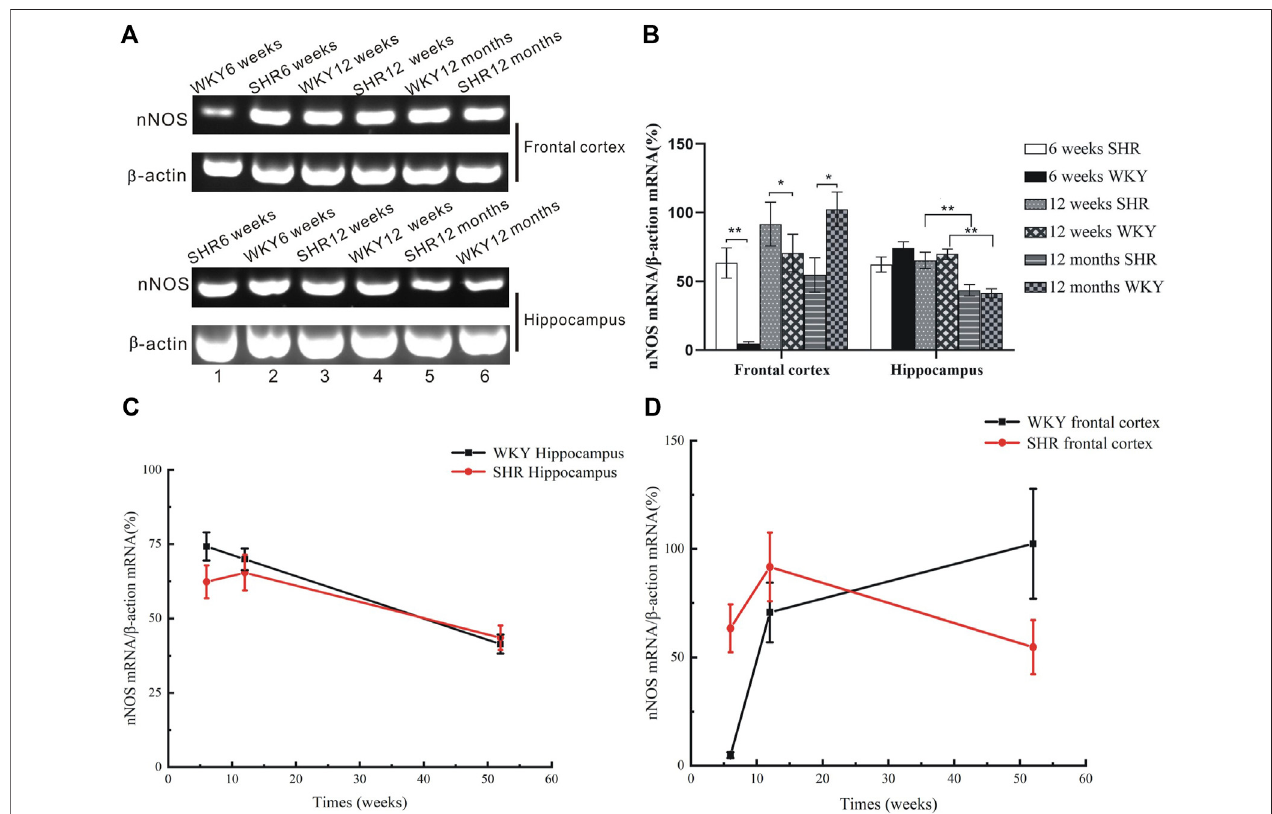
FIGURE 2 | mRNA expression of nNOS from the frontal cortex and hippocampus of SHR and WKY. (A) Agarose gel electrophoresis of PCR-ampli fi ed products nNOSmRNAsinthehippocampusofSHRandWKY.Thelocationofbandsforeachoftheproductscorrespondedtotheexpectedsimpli fi edcDNAfragmentsizebased on the choice of oligonucleotide primers. (B) The expression of nNOS was upregulated at 6- and 12 weeks postnatal stage but decreased at 12 months in the SHR, whilethenNOSexpressionincreasedatthesenescencestageinWKY.* p < 0.05verseage-matchedWKYcontrol,** p < 0.01versusage-matchedWKYcontrol. (C) ThechangeofnNOSexpressioninthefrontalcortexinagedprocessofSHRandWKY. (D) ThechangeofnNOSexpressioninthehippocampusinagedprocessofSHR and WKY.